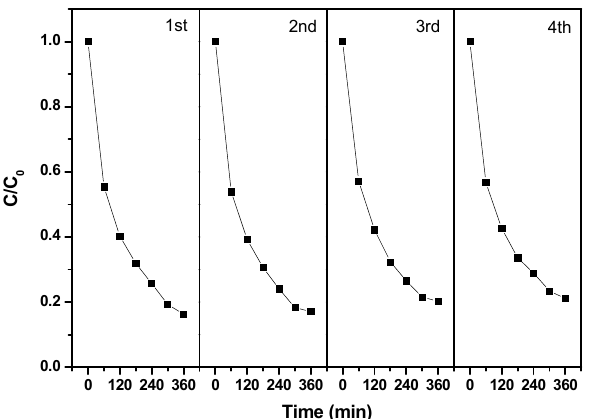
Figure 19. Repeated photocatalytic degradation tests of Direct Orange 26 with BiGdO 3 as catalyst under visible light irradiation.